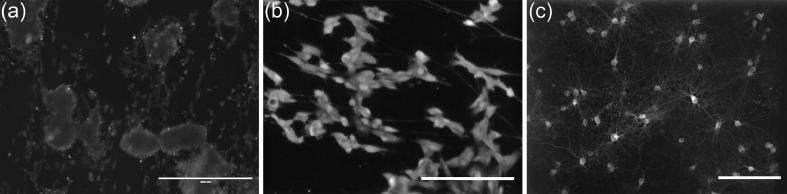
The averaged frame of each dataset. Dataset 1: A slightly active culture containing a mix of various cell types, different cell sizes and aggregates. The bar represents 400 µm (a). Dataset 2: An active culture consisting of densely-packed cells. The bar represents 200 µm (b). Dataset 3: An active culture consisting of separated cells. The bar represents 250 µm(estimated) (c).